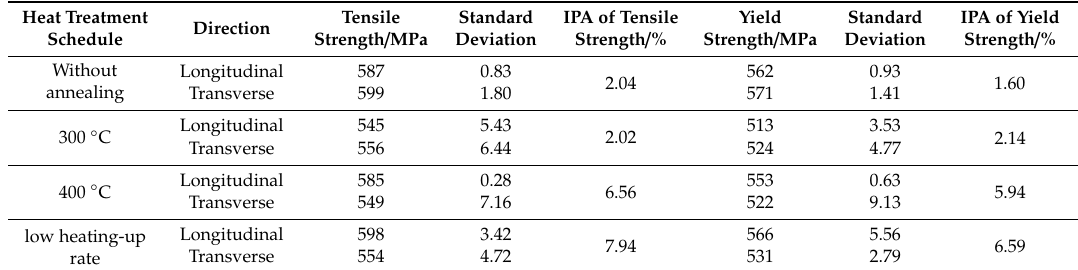
Table 5. Tensile property values of 2195 Al-Li alloy sheets with di ff erent annealing treatment after T8 aging following the solution heat